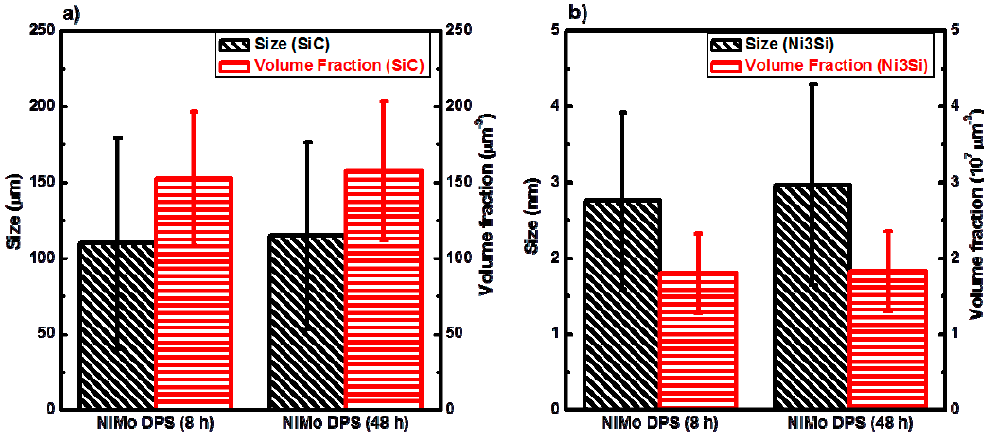
Figure 11. Size distribution and volume fraction of ( a ) SiC particles and ( b ) Ni 3 Si nano-precipitates in the 8-h-milled and 48-h-milled NiMo-2.5% SiC DPS alloys.